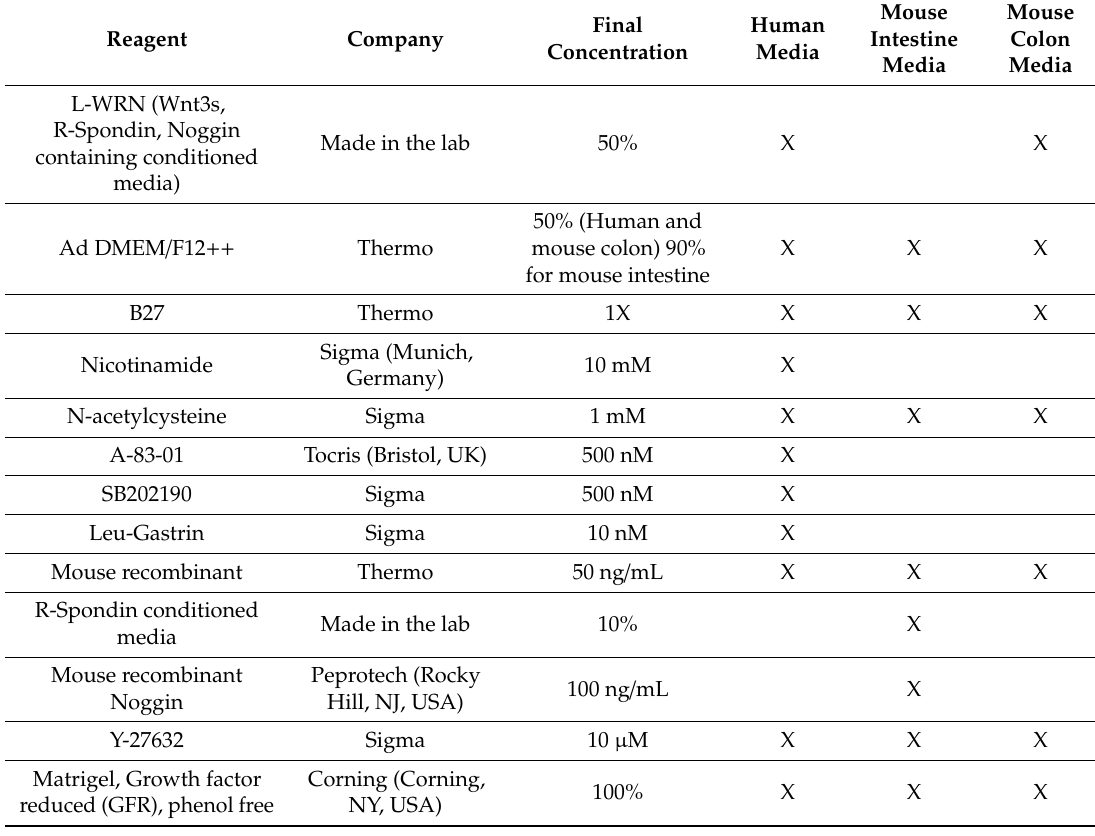
Table 1. Human and mouse media compositions tested for their ability to support feline ileum and colon organoid growth. Final concentrations and manufactures of each component are